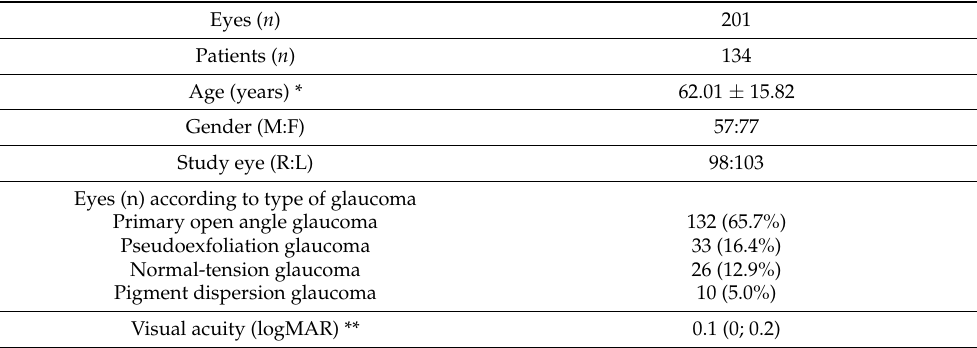
Table 1. General patient characteristics. Data on continuous variables are reported as the mean ( ± standard deviation) or the median (25th percentile; 75th percentile), depending on the data distribution.